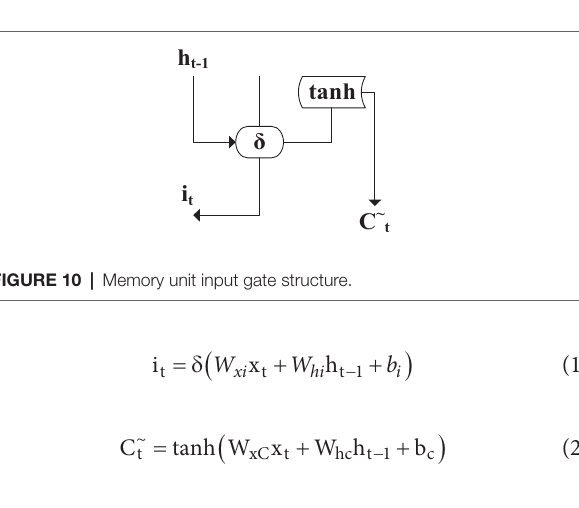
Figure 11 is the state neural layer structure (Chu et al., 2019), and the trigger output C t is solved by Equation (3):